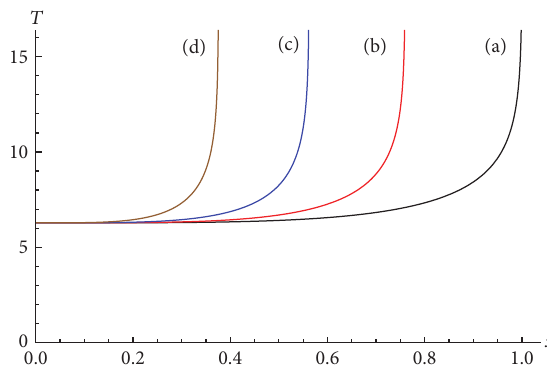
Figure 10: Exact period T in (65) as a function of the initial amplitude 𝑥 0 when 𝑎 1 = 1 , 𝑥 0 < (−𝑎 1 /𝑎 5 ) 1/4 and (a) 𝑎 5 = −1 , (b) 𝑎